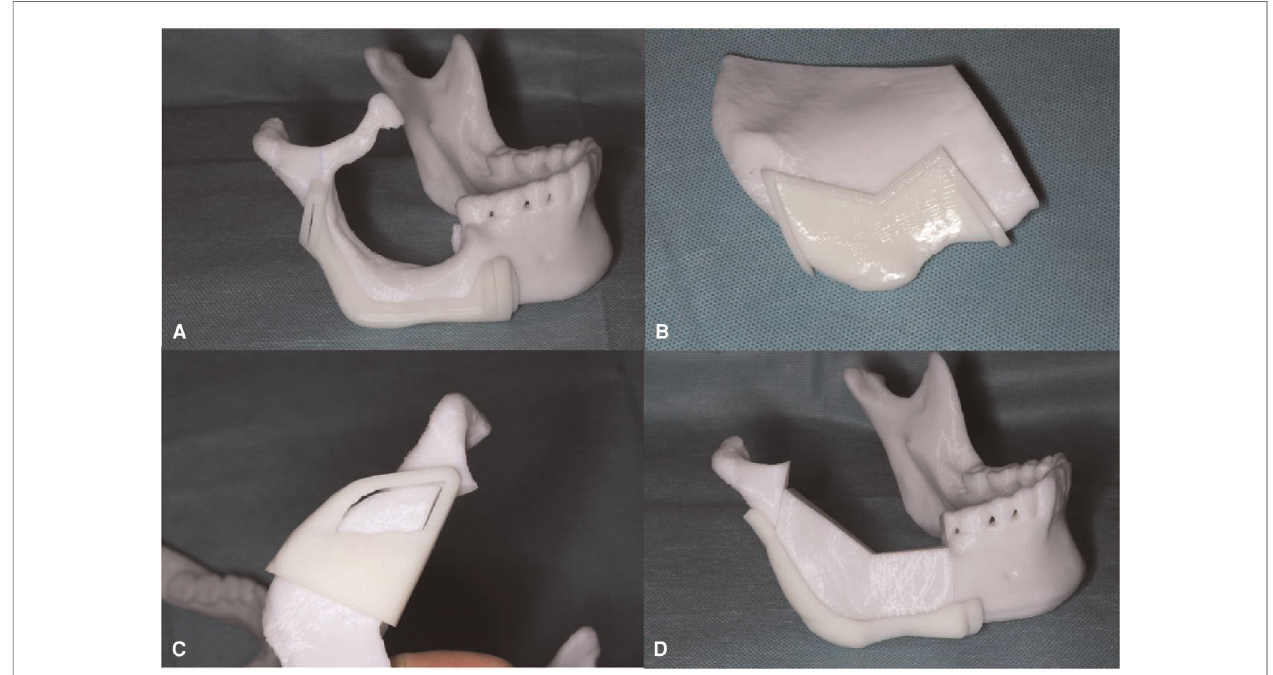
FIGURE 3 | All models and guides were printed on a three-dimensional (3D) printer: original mandible model and cutting guide ( A ); iliac model and cutting guide ( B ); shaping guide ( C ); and reconstructed mandible model and fi xation guide ( D